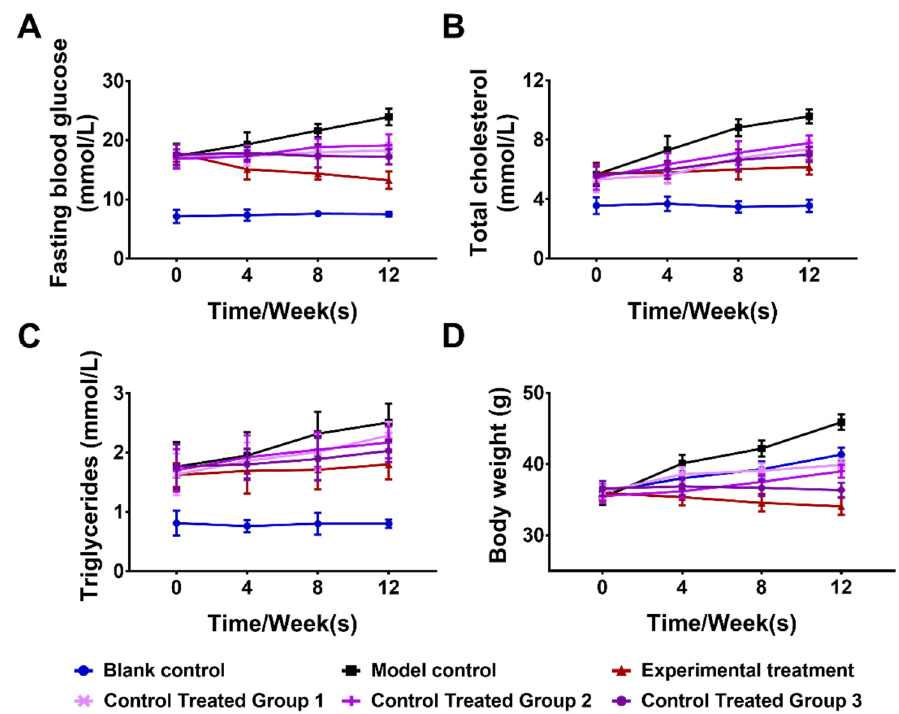
Figure 4. Effects of the synbiotic combination on the sugar and fat metabolism of mice. The effect of the synbiotic combination on fasting blood glucose (A); total cholesterol (B); triglycerides (C); body weight (D) in diabetic mice (n = 10). The blank control group was composed of wild-type mice fed a common diet and normal saline; the model control group was composed of T2DM model mice fed a high-fat diet and normal saline;